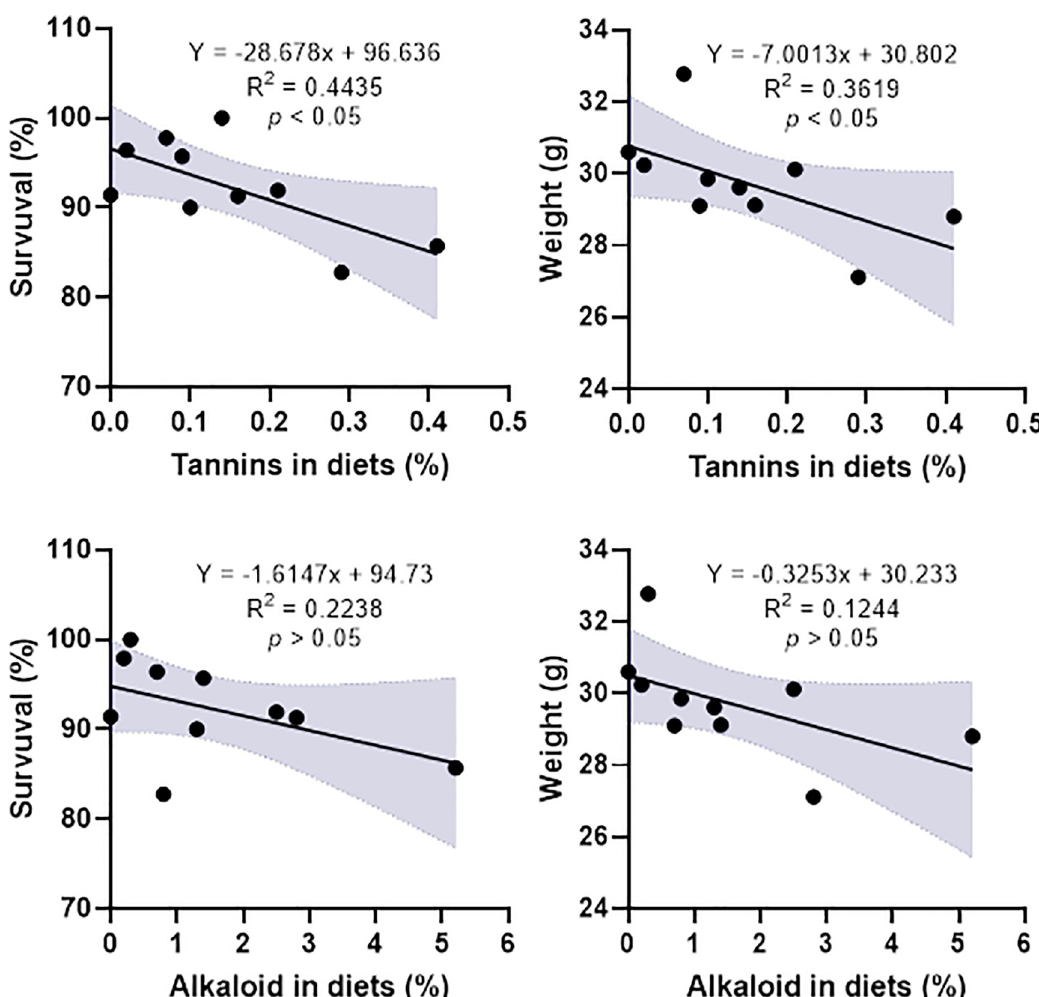
Fig 1. Regression correlation between concentrations of anti-nutritional factors (tannin and alkaloid) in diets and growth and survival of juvenile barramundi.